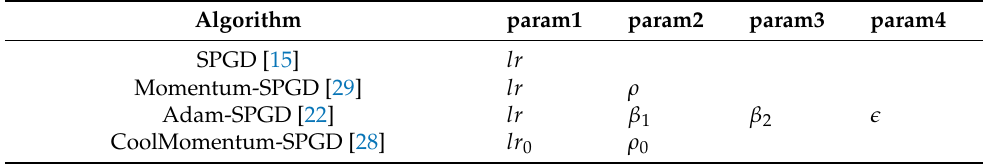
Table 1. Predefined tunable parameters